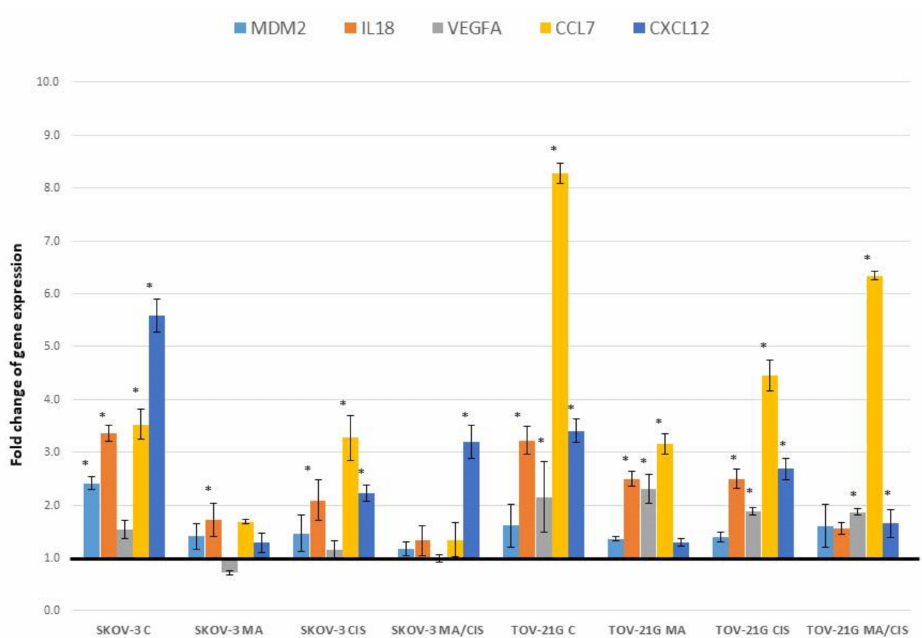
Figure 4. Effect of exosomes derived from SKOV-3 and TOV-21G cells (untreated with drugs, α - mangostin and/or cisplatin-treated) on the expression of cell growth and proliferation markers in fibroblasts. The data are shown as mean ± SD of triplicate experiments, statistically significant results * ( p <